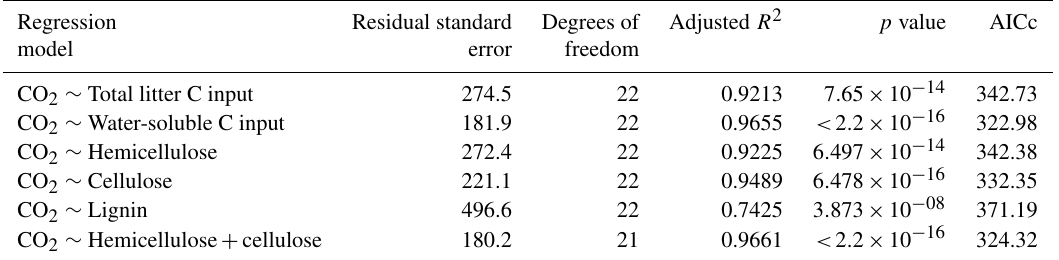
Table 6. Results of regression analyses of the relationship between total cumulative CO 2 emissions and C quality parameters of plant litter (AICc: Akaike’s information criterion).